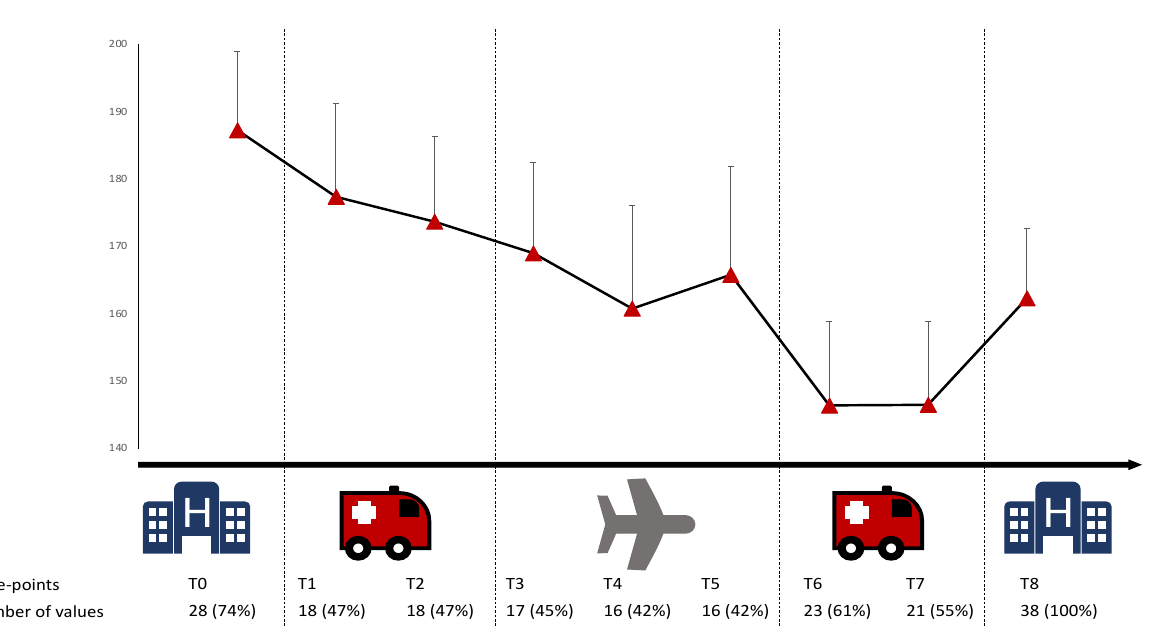
Figure 3. Evolution of SpO 2 /FiO 2 during transport + standard error of the mean. T0 = before leaving the starting ICU, T1 = at the beginning of the transport between the starting ICU and airport or drop zone (DZ), T2 = at the end of the transportation between the starting ICU and airport or DZ, T3 = at the beginning of the flight, T4 = in the middle of the flight, T5 = at the end of the flight, T6 = at the beginning of the transport between the airport or DZ and the arrival ICU, T7 = at the end of the transportation between the airport or DZ and the arrival ICU and T8 = the arrival in the final ICU.